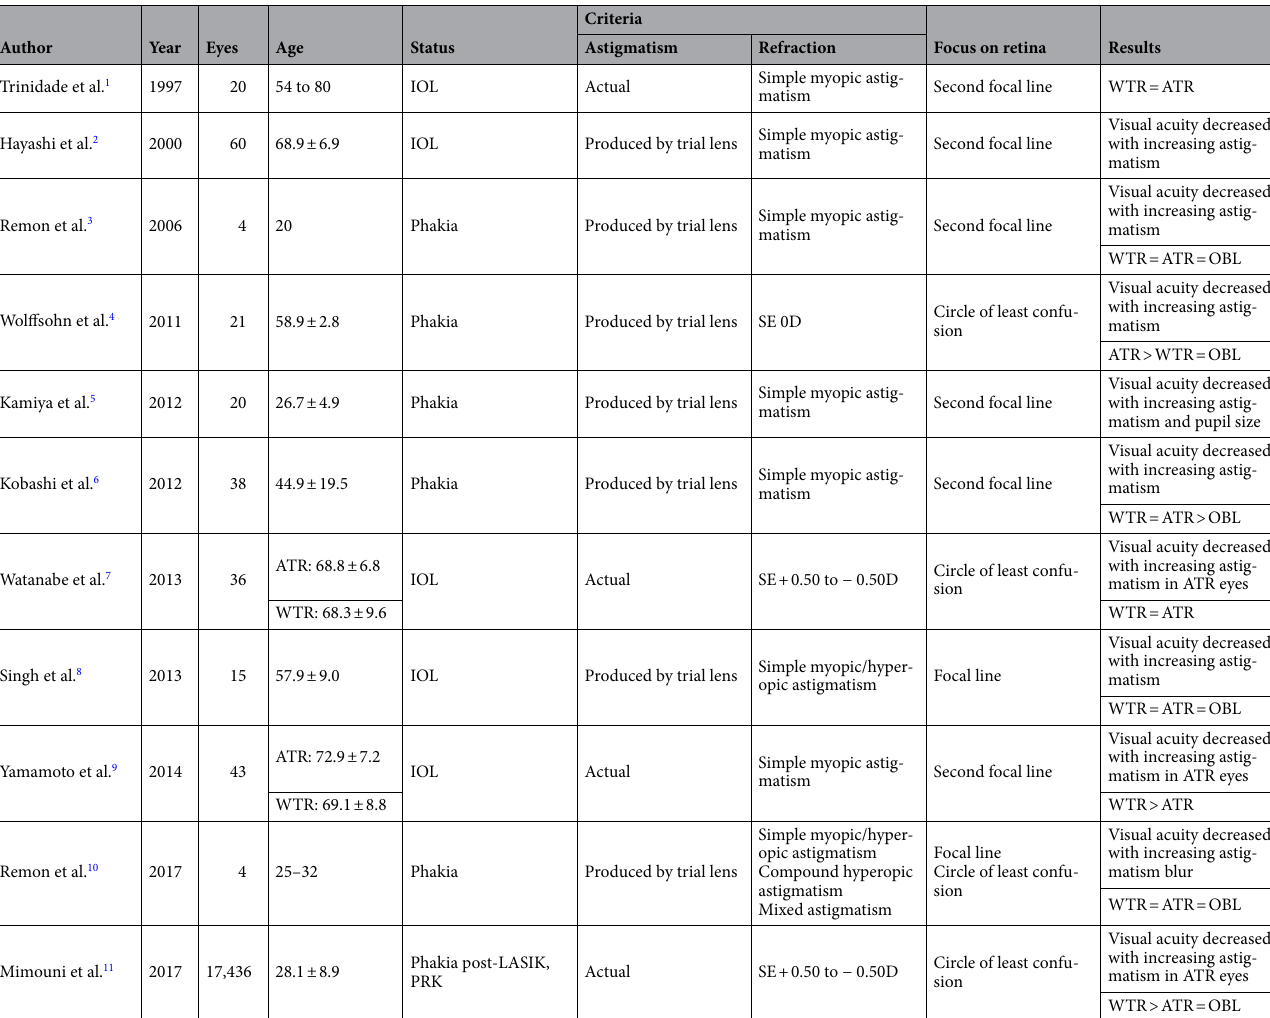
Table 3. Summary of previous studies on the effect of astigmatism on visual acuity in phakic and pseudophakic subjects. D = diopter, IOL = intraocular lens, SE = spherical equivalent, WTR = with-the-rule, ATR = against-the-rule, OBL = oblique astigmatism, LASIK = laser in situ keratomileusis, PRK = photorefractive